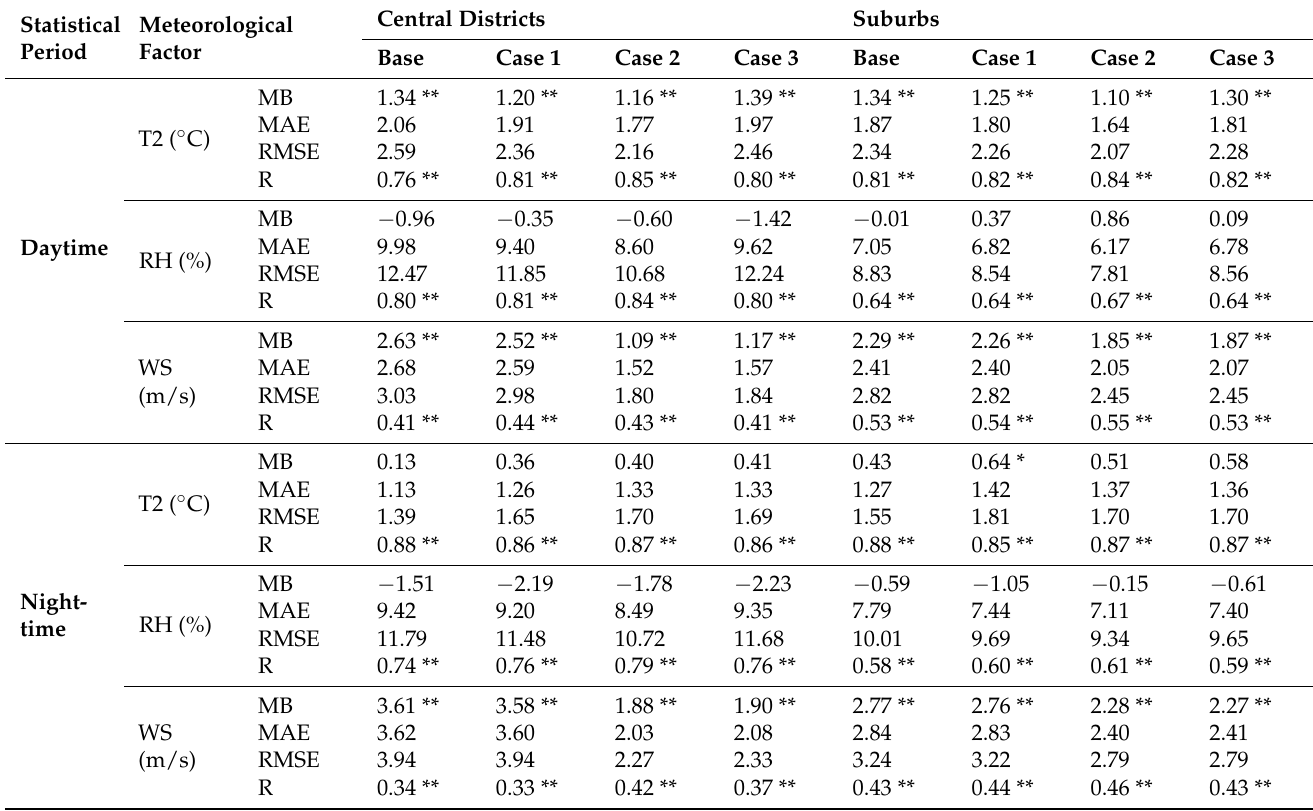
Table 4. Statistical comparison of the simulated and observed 2 m temperature (T2), relative humidity (RH), and 10 m wind speed (WS) in the urban centres and suburbs during the daytime (08:00–16:00 LST) and night-time (17:00–07:00